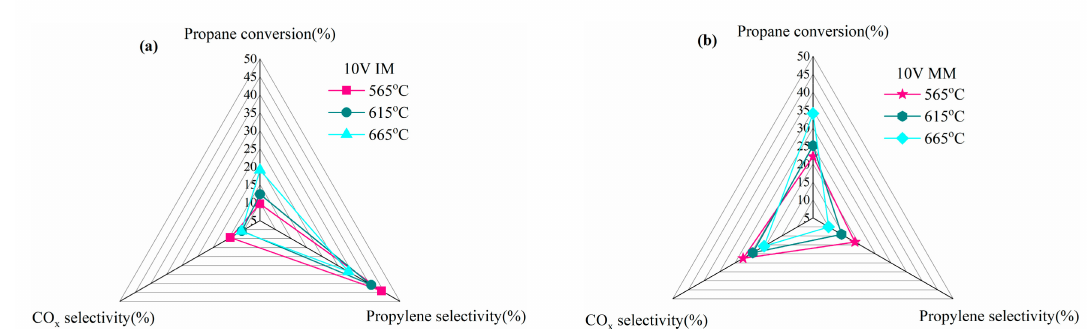
Figure 9. The initial ODHP performance for 10V IM and 10V MM at different temperatures ( a ) 10V IM, ( b ) 10V